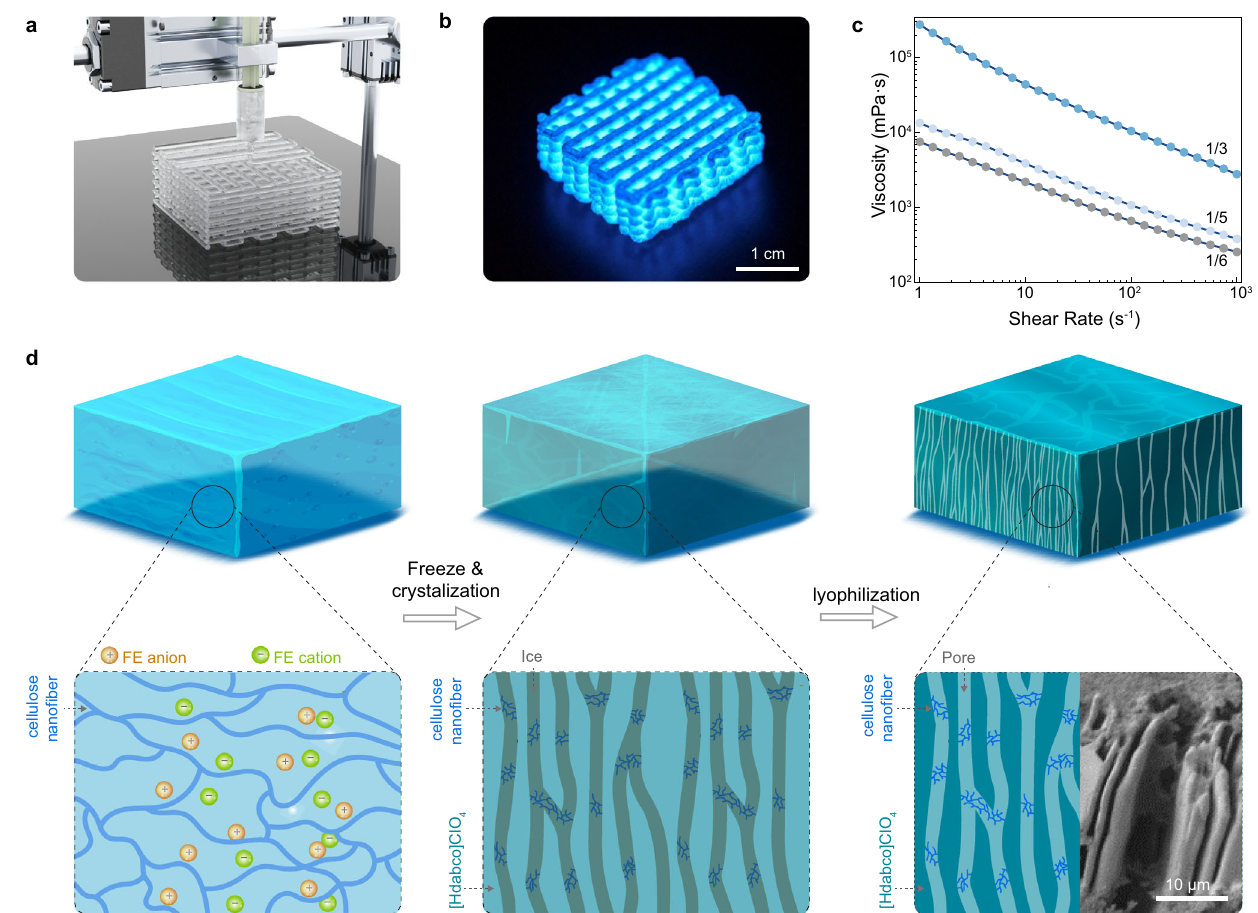
Fig. 3 | Structure design of energetic [Hdabco]ClO 4 by additive manufacturing coupled with ice-templating. a The schematic diagram of an extrusion-based 3D printing. b Optical image for the 3D printed [Hdabco]ClO 4 . Fluorescent colorants